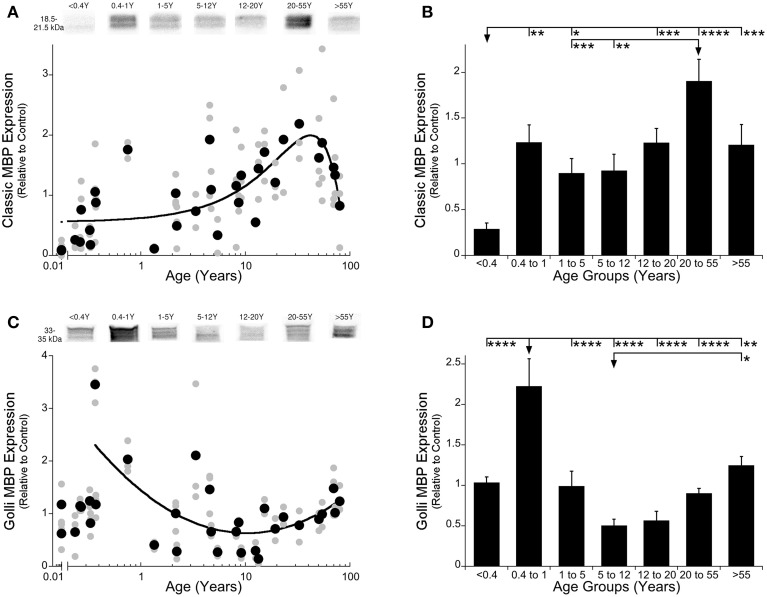
Classic- and Golli-MBP expression levels in human primary visual cortex across the lifespan. Expression levels of Classic-MBP (A,B) and Golli-MBP (C,D) are relative to control, and plotted in scatterplots and age-grouped histograms. In the scatterplots (A,C), gray symbols indicate values from individual runs, black symbols indicate the average between runs. Age is plotted on a logarithmic scale. Example bands from representative Western blots are pictured above. In the histograms (B,D), developmental age group means and standard error for each group are plotted. (A) A quadratic function was fit to all Classic-MBP data points across the lifespan (R = 0.59, p < 0.0001). A peak in expression of Classic-MBP was reached at 42 years of age (peak = 42 years 95% CI +/= 4.26 years). (B) Significant differences among age groups are identified (ANOVA, F = 10.248, p < 0.0001), and Tukey's post-hoc comparisons were made between groups (* p < 0.05, ** p < 0.01, *** p < 0.001, **** p < 0.0001). (C) An inverse quadratic function was fit to all the Golli-MBP data points older than 0.4 years of age (R = 0.61; p < 0.0001). The minimum expression was reached at about 10 years of age (minimum = 10.3 years 95% CI ± 3.8 years). (D) Significant differences among age groups are identified (ANOVA, F = 10.955, p < 0.0001), and Tukey's post-hoc comparisons were made between groups (*p < 0.05, **p < 0.01, ***p < 0.001, ****p < 0.0001).